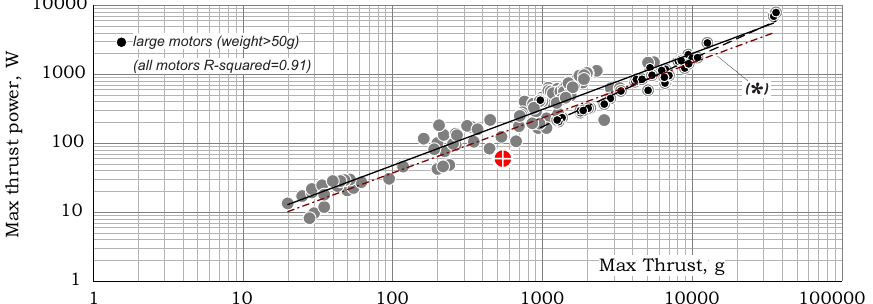
Figure 9. Single propeller power consumption design trend, [17,18]. Full line: all motors; Dashed line: large motors.